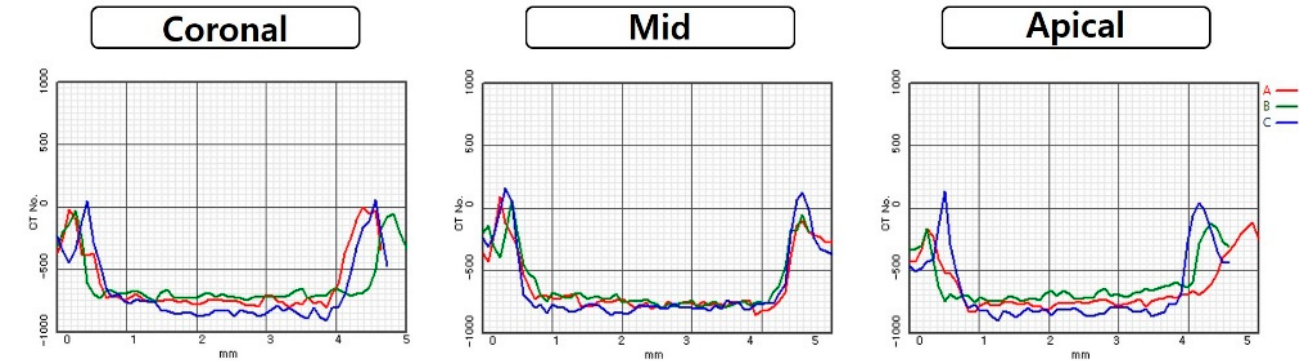
Figure 4. Comparison of Hounsfield unit gaps according to area at 4.8 mm diameter of conventional